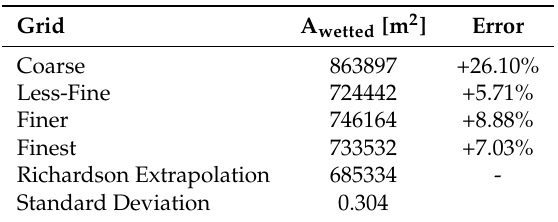
Table 3. Wetted area for all meshes and Richardson extrapolated area. Error is given in percentage of the Richardson extrapolated value. Grid A wetted [m 2